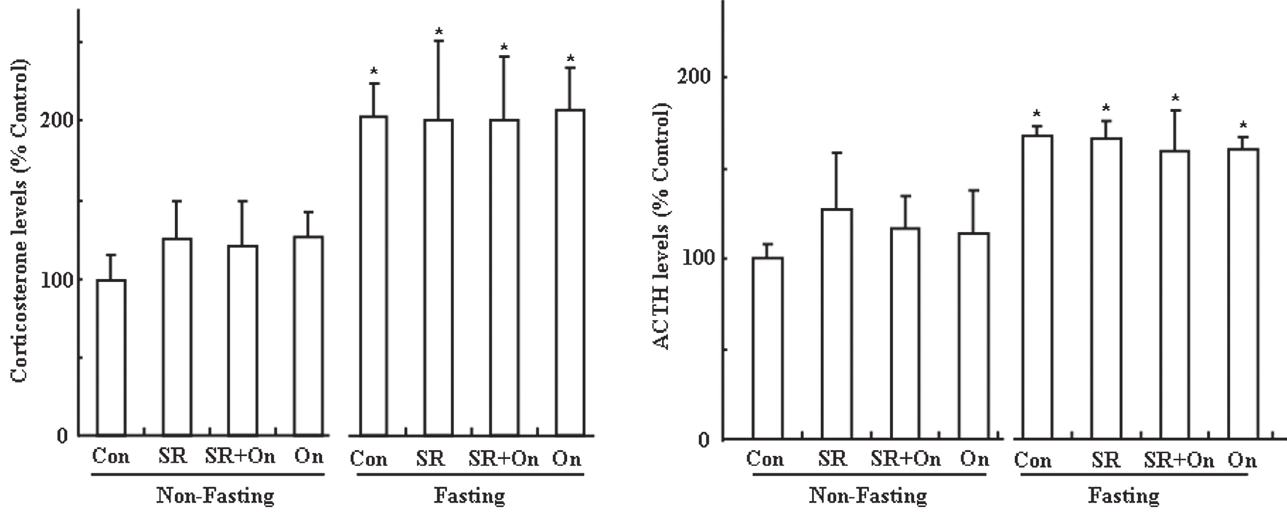
Fig 7. Corticosterone and ACTH levels, normalized to control, in fed and fasted mice. Con: control group; SR: SR 57227 (10 mg/kg, i.p.); On: ondansetron (3 mg/kg, i.p.). Values are means ± SEM (n = 6 or 7). * , P < 0.05 vs. non-fasting control